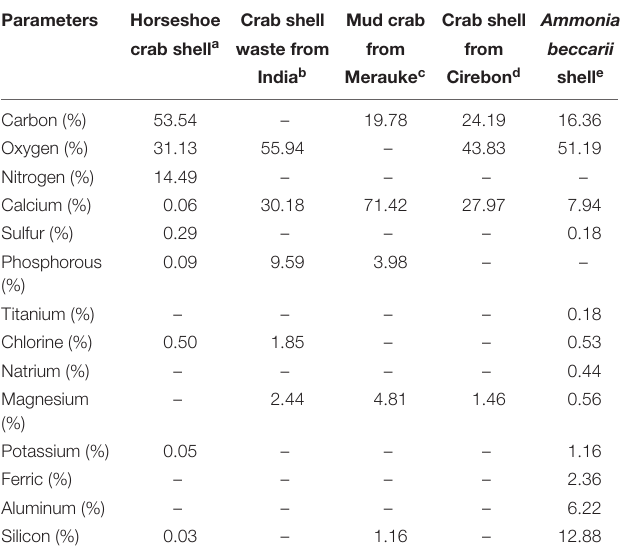
TABLE 3 | Element levels of the shells in mangrove horseshoe crabs ( Carcinoscorpius rotundicauda ) and some other crustaceans. Parameters